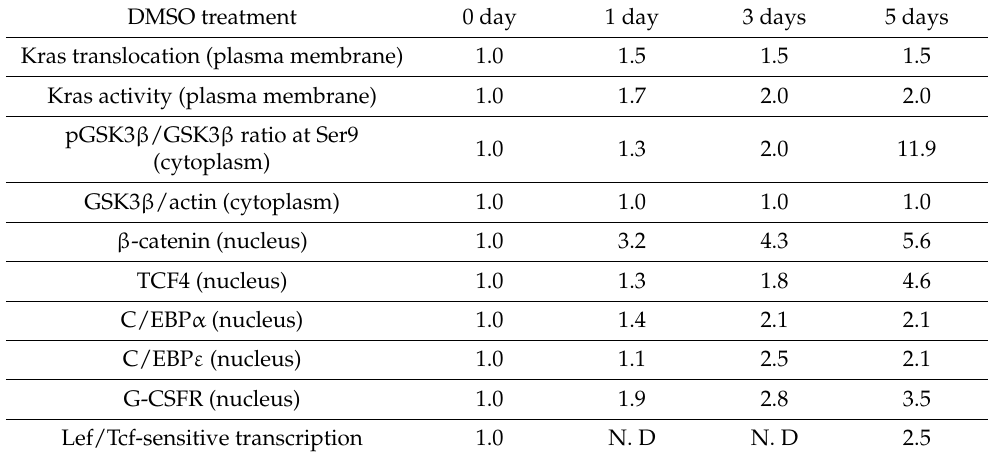
Table 1. Changes in various parameters in response to DMSO treatment in HL-60